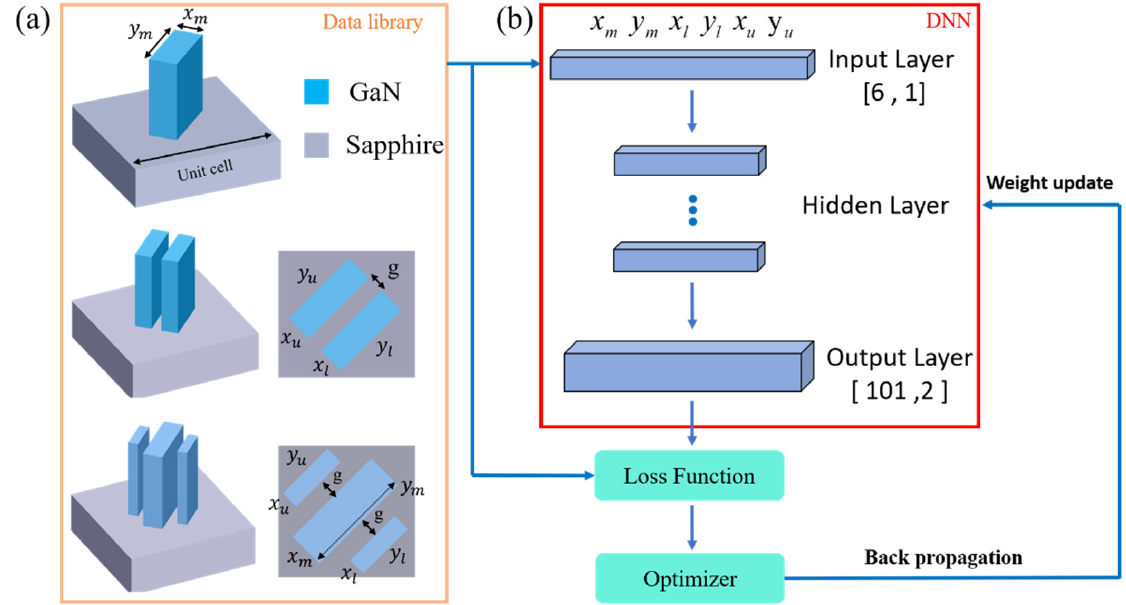
Figure 2. Proposed methodology for the broadband achromatic metalens. ( a ) The original data li- brary includes different numbers of nanofins calculated by the FDTD method. ( b ) The architecture of deep neural network where the output layer is the phase delay and the conversion efficiency. There are 101 steps at wavelengths from 400 to 650 nm. The gap is 60